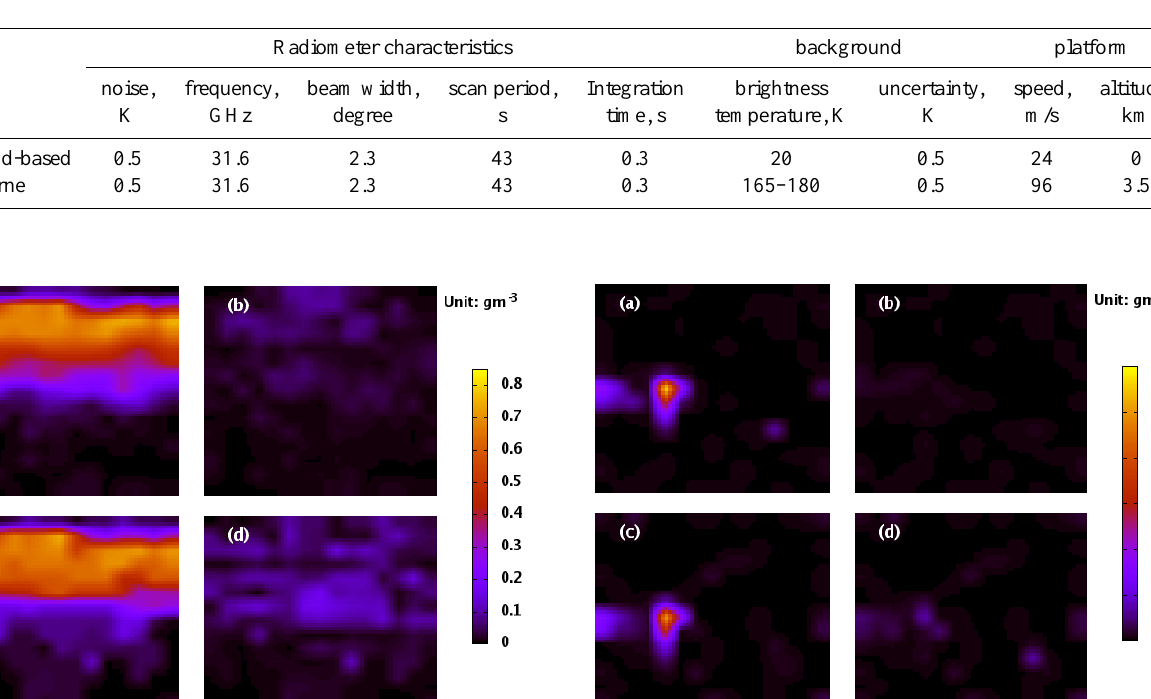
Table 1. The typical radiometer specifications, background characteristics, and platform parameters of the ground-based and airborne cloud tomography configurations.